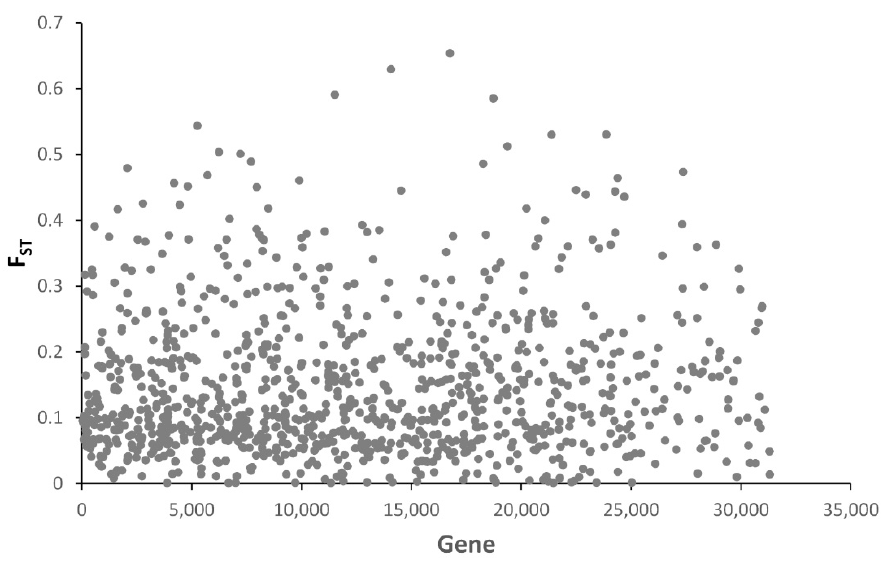
Figure 3. Distribution of average Fst values among populations of Epiphyas postvittana calculated from the SNPs within gene models in the genome.